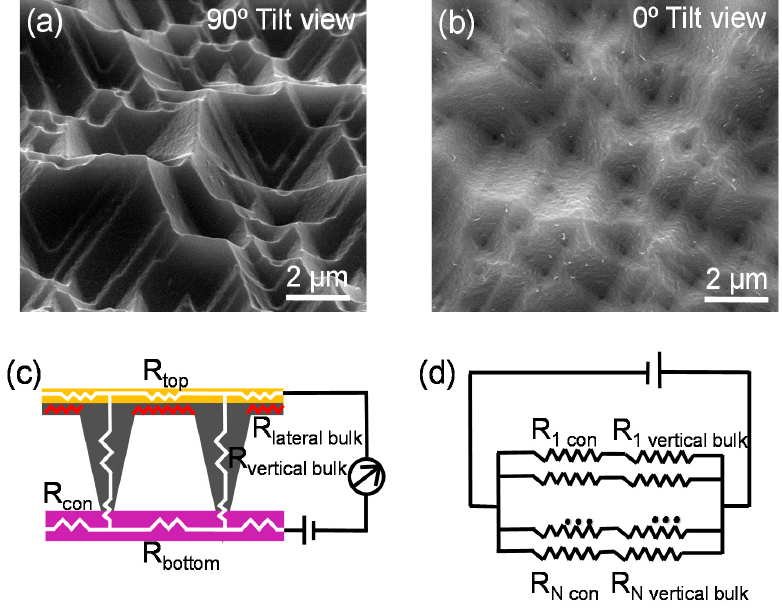
Figure 2. SEM images of conductive layer with pyramid-like patterns ( a ) with 90° tilt view and ( b ) with 0° tilt view. ( c ) A simple circuit model corresponding to random individual pyramid-like microstructure. The pressure independent lateral bulk transporting resistance ( R lateralbulk , red folding line) is replaced by top electrode resistance ( R top ). ( d ) The proposed equivalent circuit diagram of entire sensor.